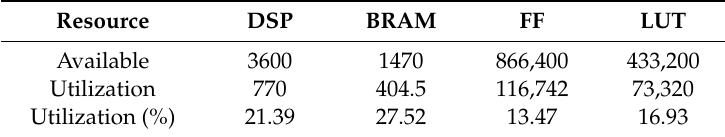
Table 3. Resource utilization of the proposed hardware